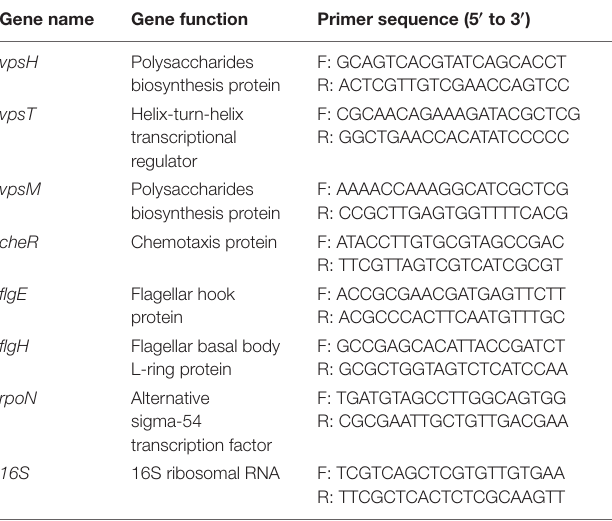
TABLE 1 | Primers used for